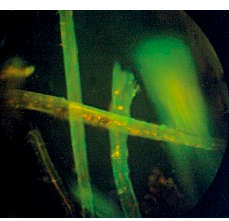
Figure 3. Dew retted hemp fibers activity towards Staphylococcus aureus bacteria, the killed bacterias take the form of orange particles. The strains of the clinical Staphylococcus aureus bacteria were isolated from ill people after 90 min of